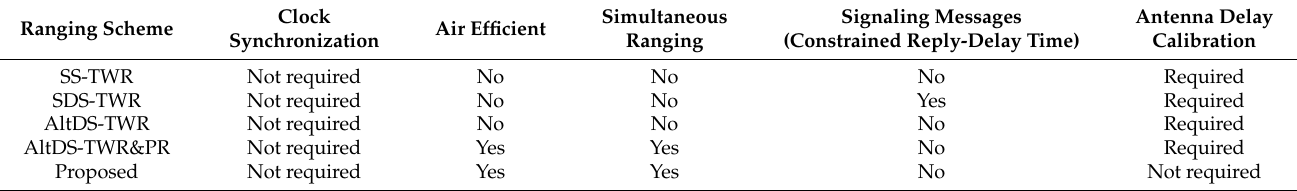
Table 4. Comparison of the proposed scheme to other state-of-the-art TWR schemes in terms of some basic desirable features of UWB-based